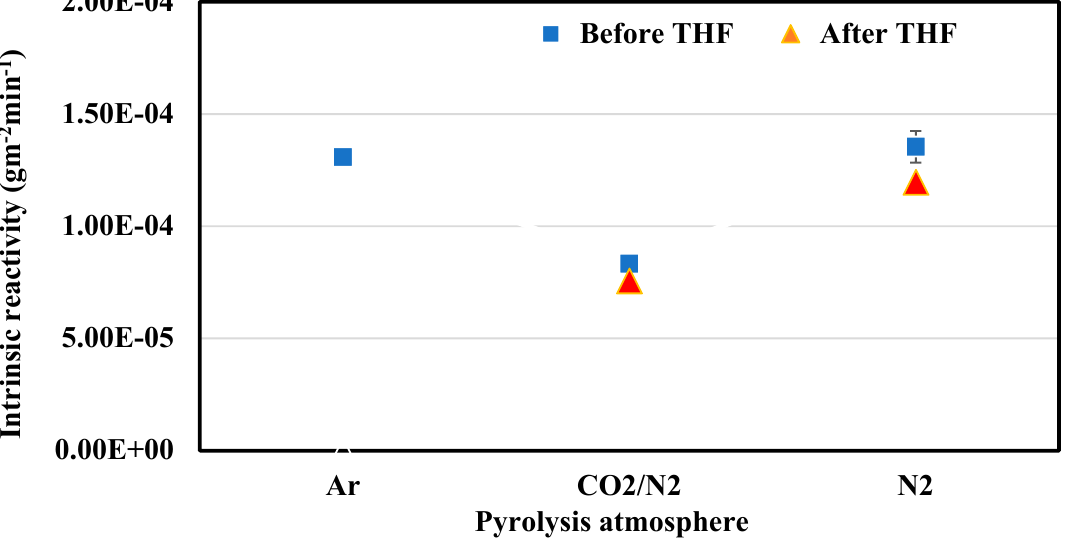
Table 5. Values of L a and L c for chars (before washing with THF).